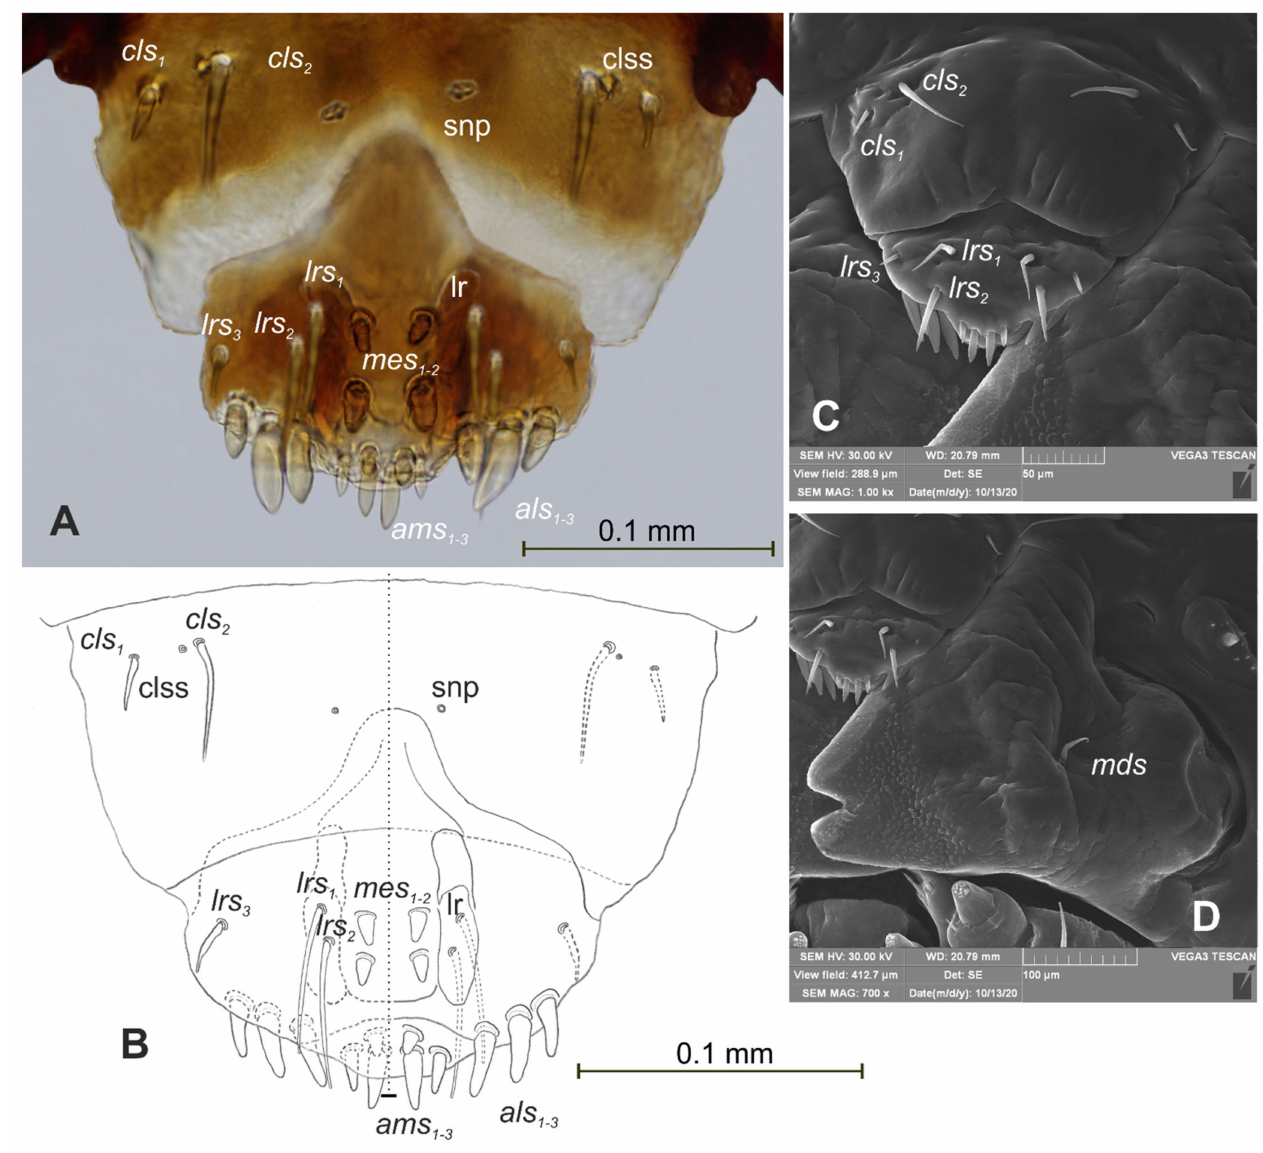
Figure 16. Rhinocyllus alpinus mature larva, mouthparts. ( A )—clypeus, labrum, and epipharynx, photo; ( B )—clypeus, labrum and epipharynx, scheme; ( C )—clypeus, labrum, and epipharynx, Scheme 17. Rhinocyllus alpinus mature larva, maxillolabial complex. ( A )—maxillolabial complex, ventral aspect, photo; ( B )—maxillolabial complex, ventral aspect, scheme; ( C )—apical part of right maxilla, dorsal aspect; ( D )—apical part of right maxilla, ventral aspect; (setae: dms — dorsal malar, ligs —ligular, mbs —malar basiventral, mps —maxillary palp, pfs —palpiferal, prms —prelabial, pms —postlabial, stps —stipal, vms —ventral